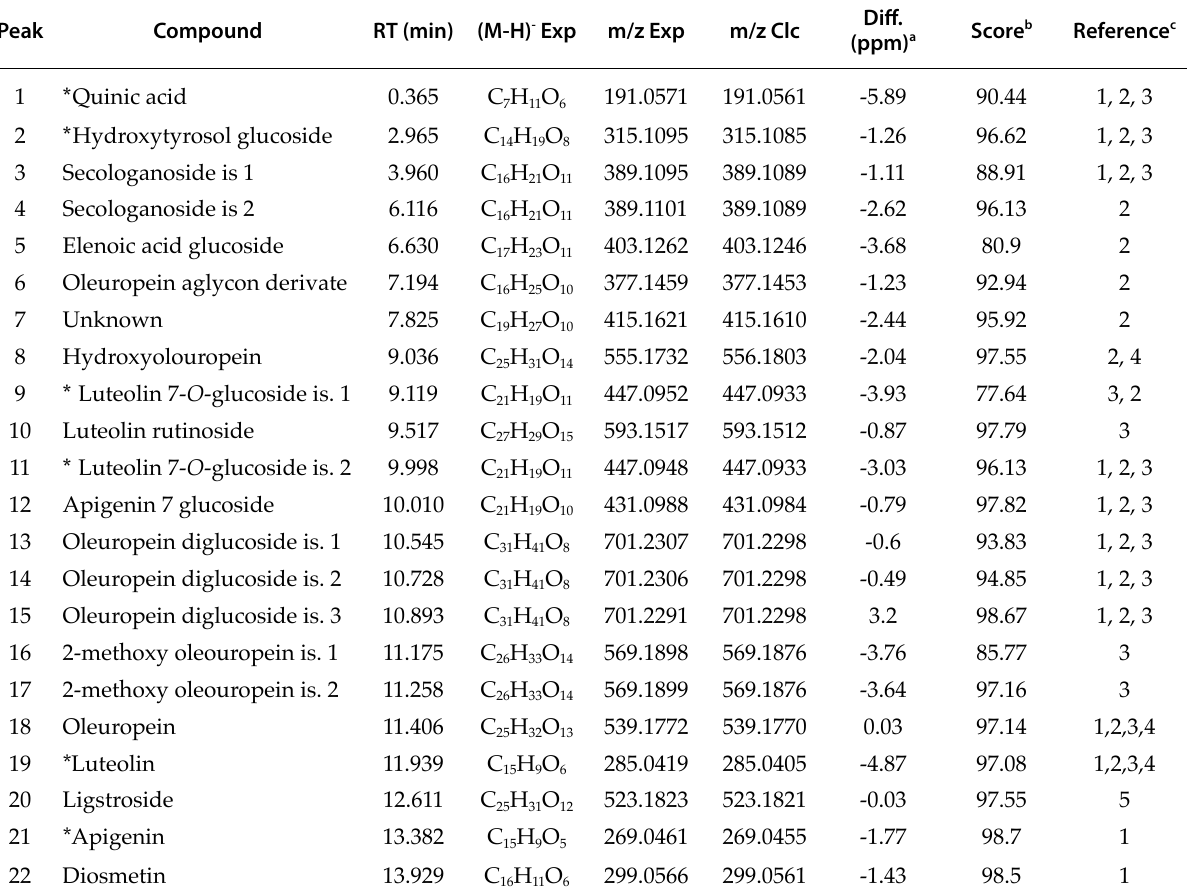
Table 4. Characterization of olive leaf extract by HPLC-ESI-TOF (ion M-H) - . Exp = experimental; Clc = calculated.